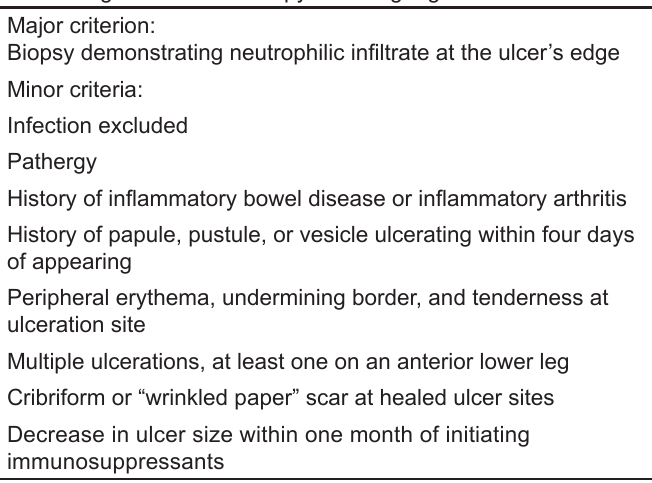
Table. Diagnostic criteria for pyoderma gangrenosum.